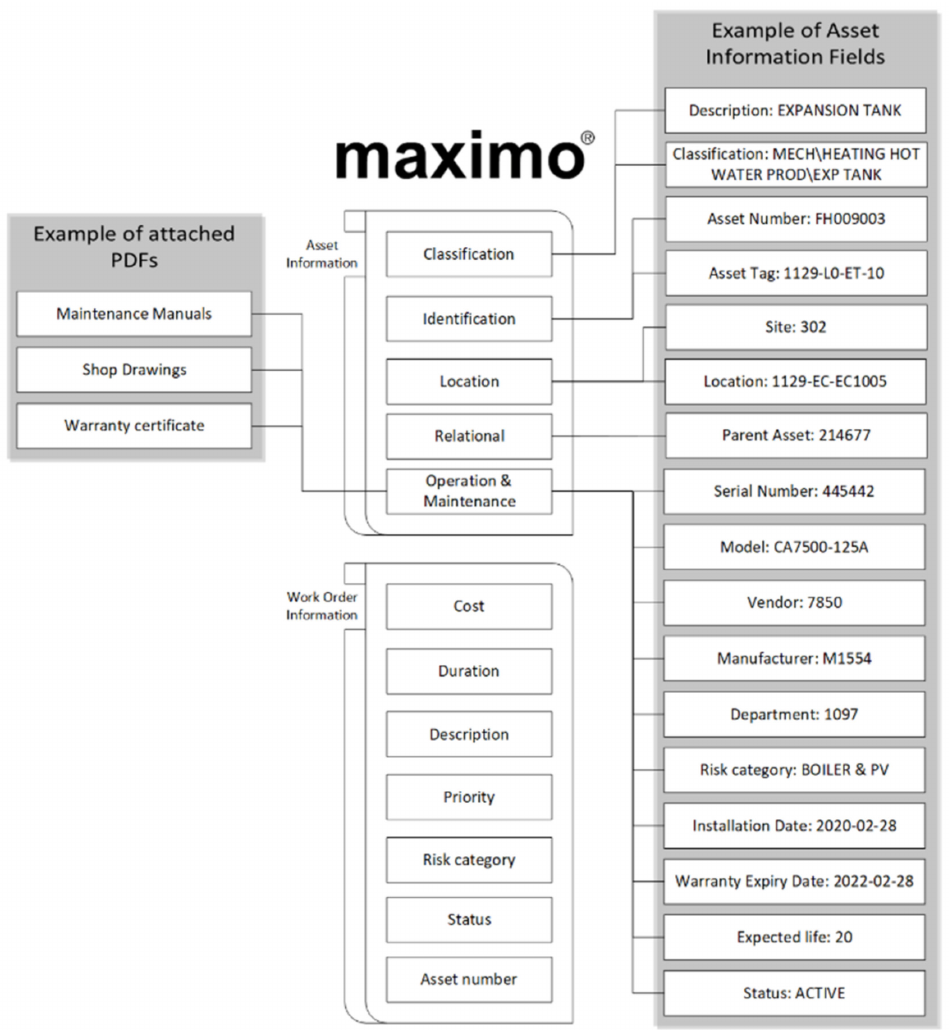
Figure 14. Representation of different types of information available per asset in the CMMS in the operations